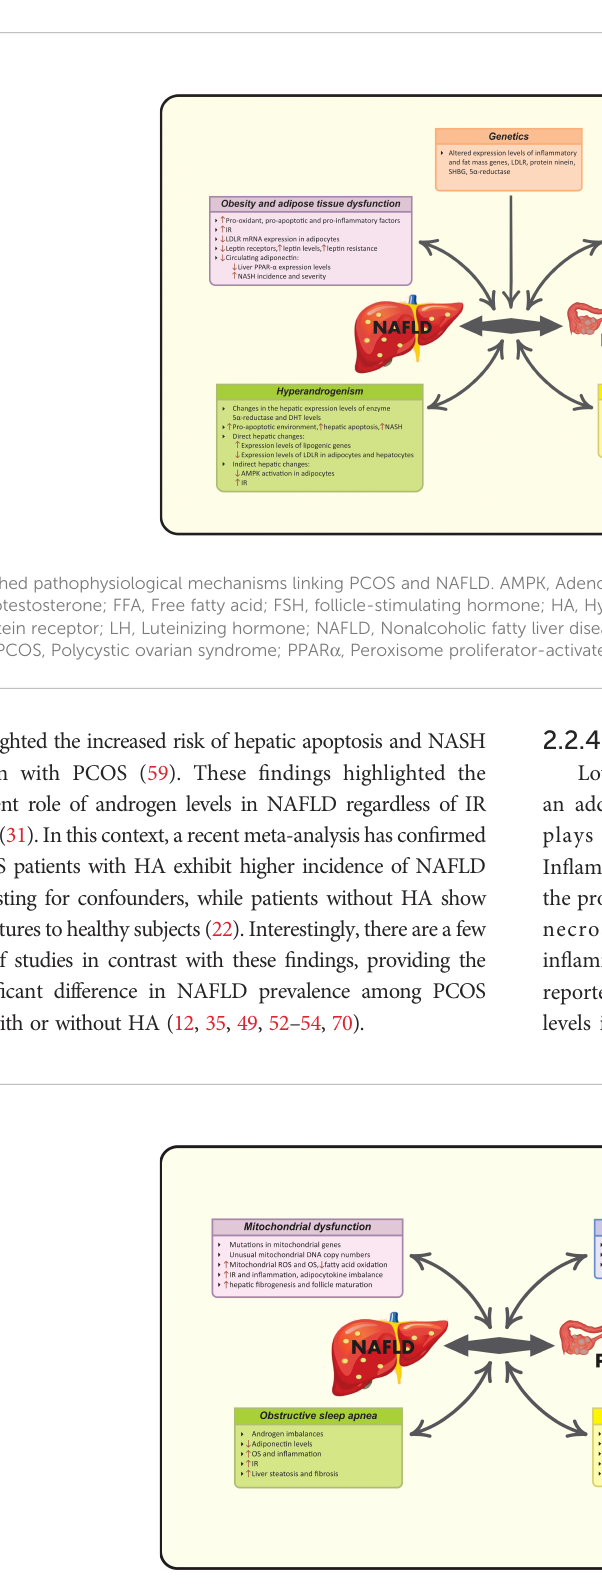
FIGURE 2 Possible new pathophysiological mechanisms linking PCOS and NAFLD. HA, Hyperandrogenism; IR, Insulin resistance; NAFLD, Nonalcoholic fatty liver disease; OS, Oxidative stress; PCOS, Polycystic ovarian syndrome; ROS, Reactive oxygen